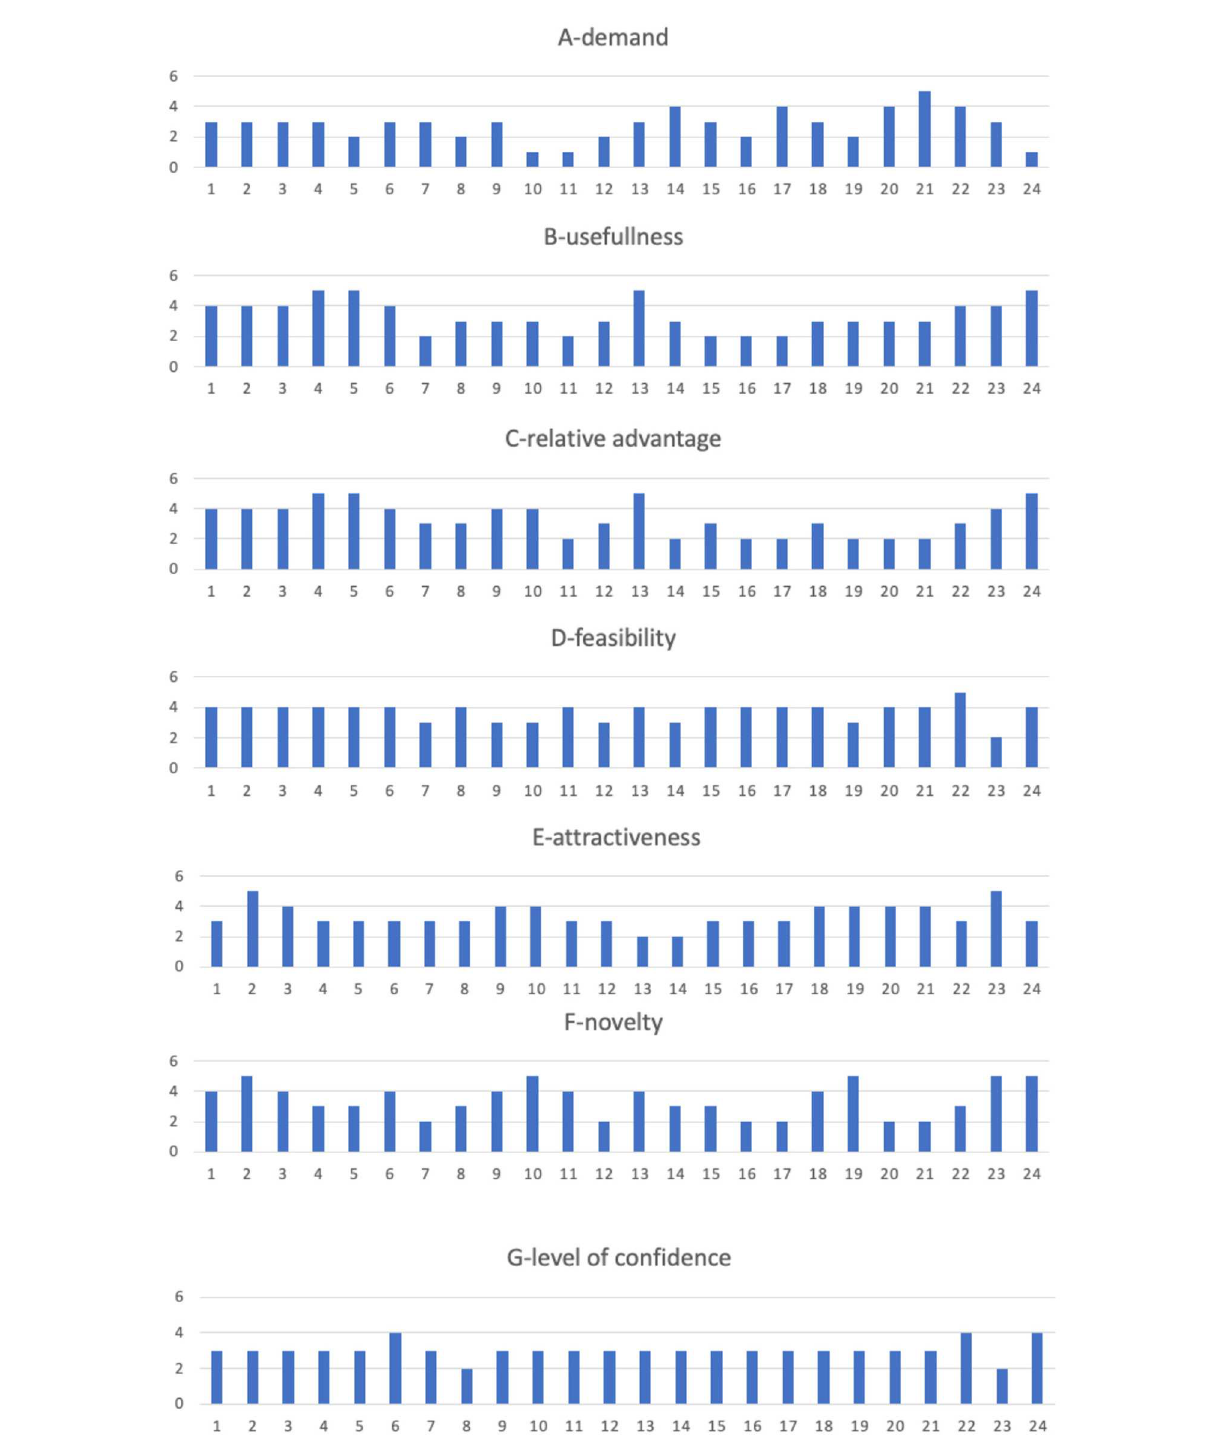
FIGURE5 Evaluation of the analyzed robotic solutions. Seven criteria were used to evaluate each of the analyzed solutions, namely, A-demand, B-usefulness, C-relative advantage, D-feasibility, E-attractiveness, F-novelty, G-level of confidence. Each diagram compares, for each criterion, the evaluations collected for the 24 analyzed